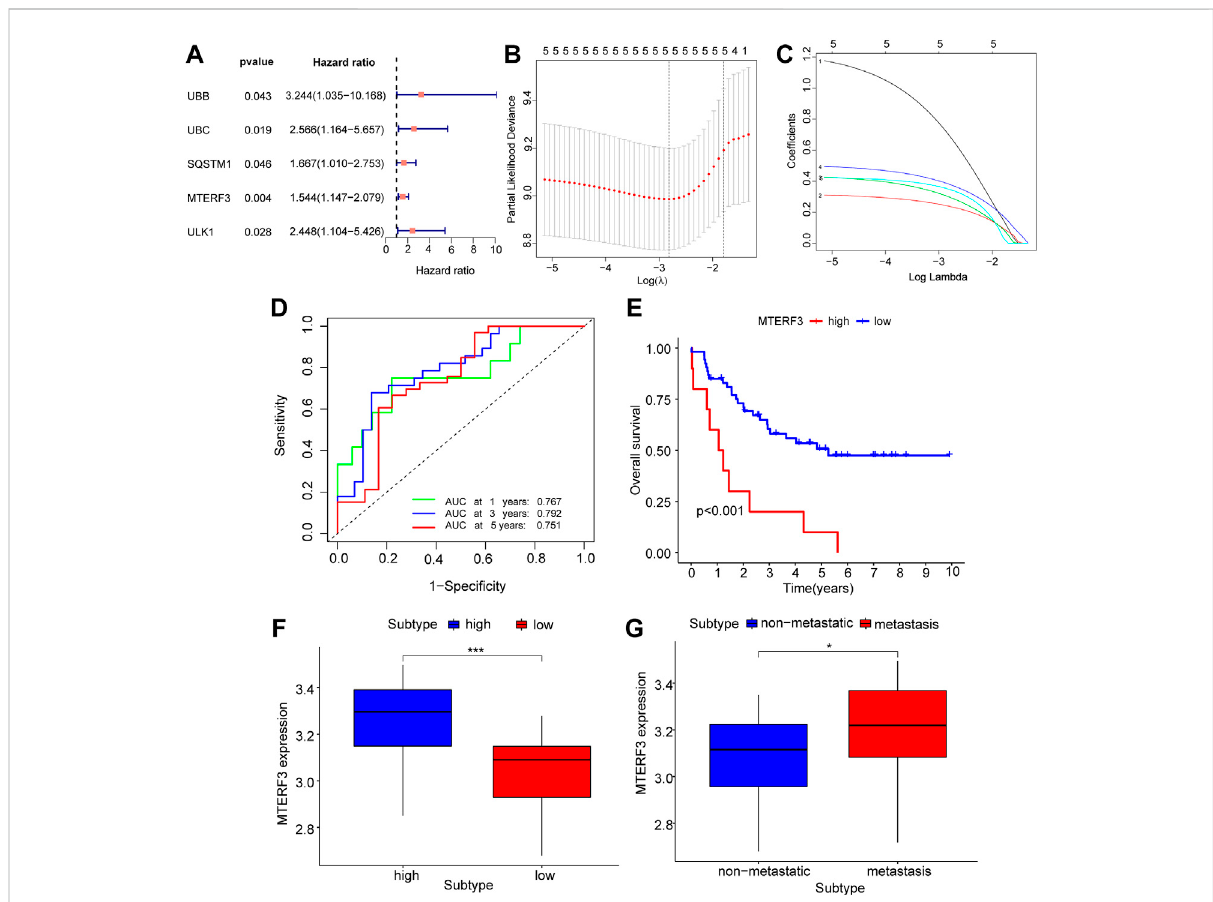
FIGURE 8 GEO dataset validates key mitophagy-related genes. (A) Forest diagram showing the results of COX regression analysis of mitophagy-related genesbasedontheGEOdataset. (B,C) Prognosismodeldiagram (B) andvariabletrajectorydiagram (C) ofLASSOregressionanalysismodelbasedon the GEO dataset of mitophagy-related genes. (D) The time-dependent ROC curve results of Riskscore of the LASSO model based on the GEO dataset, green is the AUC of patients who survived for one year, blue is the AUC of patients who survived for three years, and red is the AUC of patientswhosurvivedfor fi veyears. (E) KMcurveresultsofsurvivalanalysisoftheLASSOmodelwithhighandlowRiskscoregroups,showthatblueis the low-risk group and red is the high-risk group. (F – G) Based on the GEO dataset, the results of group comparison between the high and low Riskscore groups (F) and whether to transfer group (G) of mitophagy-related gene MTERF3 in the LASSO model. High risk group in blue, low risk group inred (F) ;blue represents thenon-metastasized group, red represents themetastasized group (G) . The closer theAUC in ROC curvewas to 1, thebetter thediagnosticeffectwas. TheAUChaslow accuracywhenitisbetween 0.5and0.7.The AUChasacertainaccuracybetween 0.7and0.9. The accuracy is higher when the AUC is above 0.9. Ns, not signi fi cant; *, p < 0.05; **, p < 0.01; ***, p < 0.001. LASSO, least absolute shrinkage and selection operator; KM, Kaplan – Meier; ROC, receiver operating